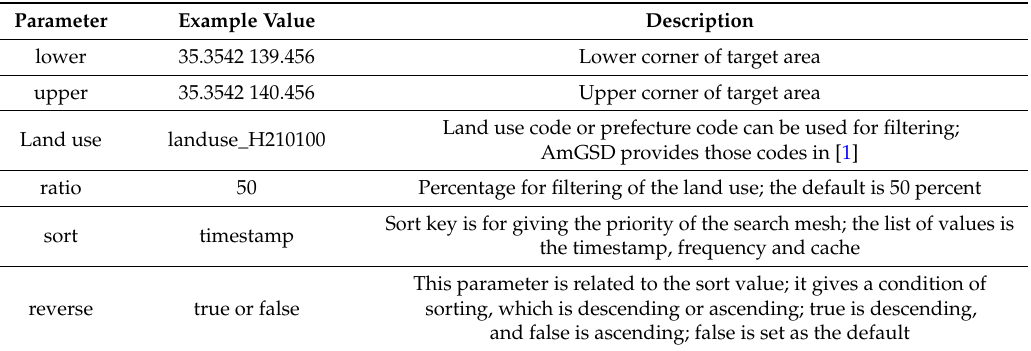
Table 7. Request parameters of the Mesh Info